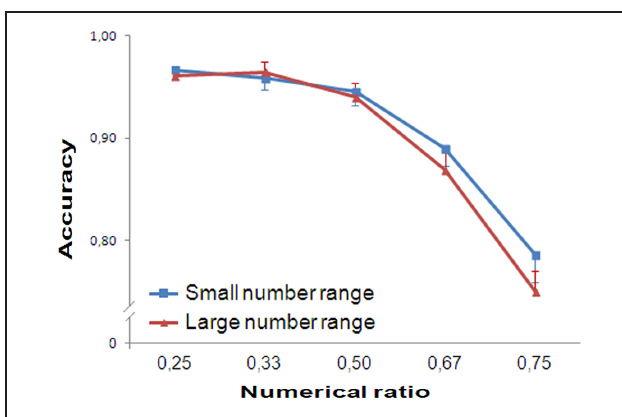
FIGURE 2 | Results of Experiment 1. Accuracy is plotted against the numerical ratio of the contrasts for both small (1–4) and large number range (6–24). The performance of the participants showed ratio dependence for both small and large numbers. Bars in this and the following graphs represent the standard error.